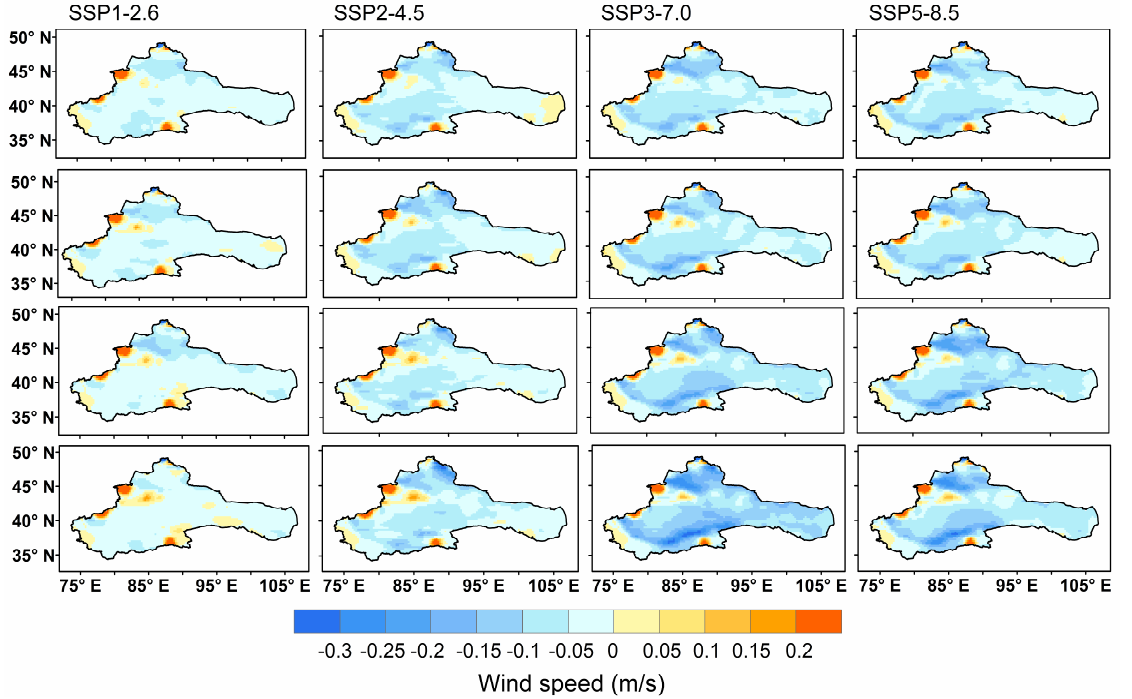
Figure 5. Spatial difference distribution of NF (row 1), MF (row 2), FF (row 3), and FP (row 4) relative to BP (1995–2014) under four emission scenarios.